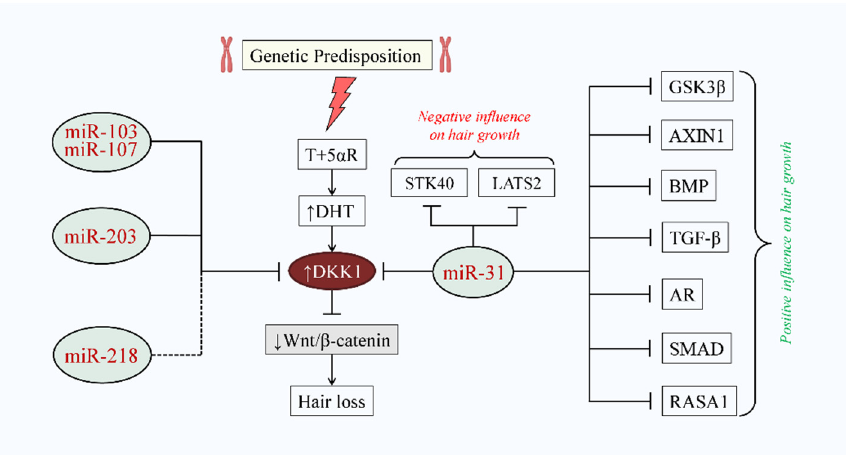
Figure 5. Potential implication of DKK1-targeting key miRNAs in genetically predisposed hair loss. In a genetically predisposed population, T is converted to DHT by 5 α R. Upregulated DHT induces DKK1 expression. DKK1 inhibits Wnt/ β -catenin signaling and hair loss takes place. miR-103/107, miR-203, and miR-218 reduce the DKK1 level, which might prevent hair growth, while miR-31 potentially inhibits DKK1 and other proteins that might also modulate the hair growth cycle. Abbreviations: T, testosterone; DHT, dihydrotestosterone; 5 α R, 5 alpha-reductase; DKK1, dickkopf-related protein 1; GSK-3 β , glycogen synthase kinase 3 β ; STK40, serine/threonine kinase 40; LATS2, large tumor-suppressor kinase 2; BMP, bone morphogenetic protein; TGF- β , transforming growth factor- β ; AR, androgen receptor; RASA1, RAS p21 protein activator 1. Dashed line indicates the indirect inhibition of DKK1.